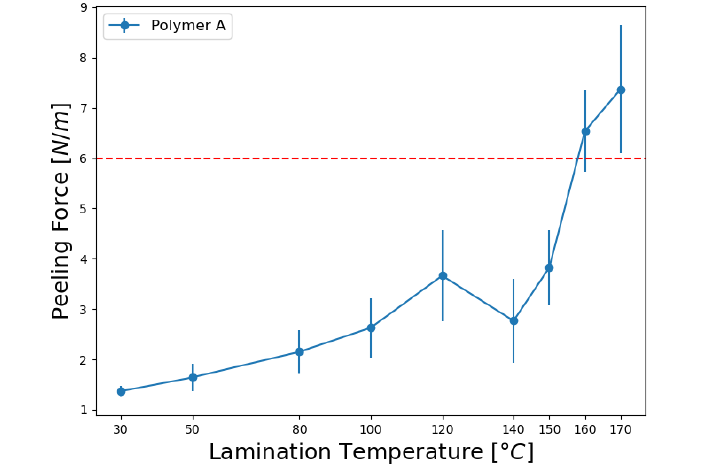
Figure 4. Peeling test on ceramic separator with Polymer A depending on lamination temperature. Cohesion failure of the ceramic separator starts occuring at stresses above 6